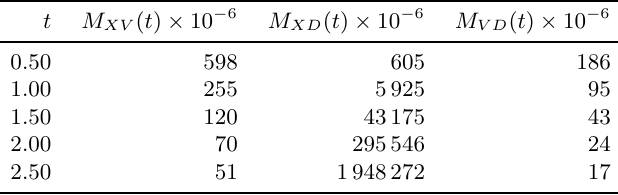
M XV ( t ) , M XD ( t ) and M V D ( t ) as a function of t with C = 3 , N = 412 , n = 98 000 ,